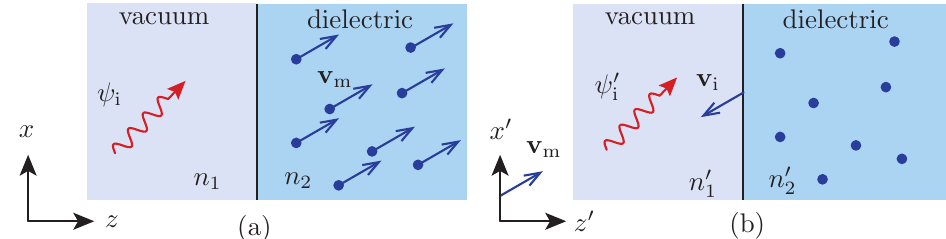
Figure 10. Comparison of two closely related problems involving motion. ( a ) Problem studied in this paper; ( b ) Related spacetime-modulated problem. In both cases, we assume that the incident = 1, and the transmission medium a dielectric fluid that is isotropic medium is vacuum, i.e., n 1 = n (cid:48) 1 at